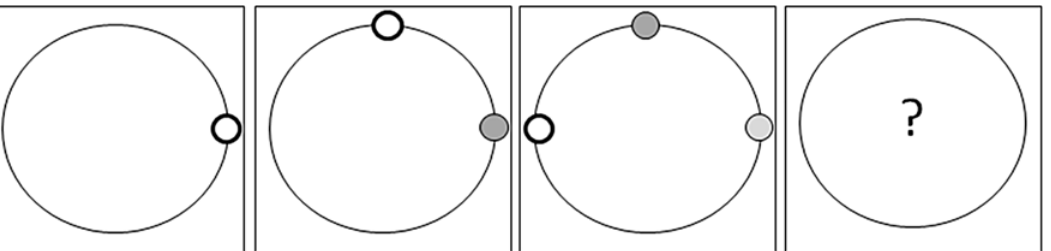
Fig 1. A sample schematic representation for a low difficulty pattern in the computer-based problem-solving task. Participants are asked to continuously indicate the assumed next position of the little white circle while its previous positions fade from dark grey to lighter shades of grey.